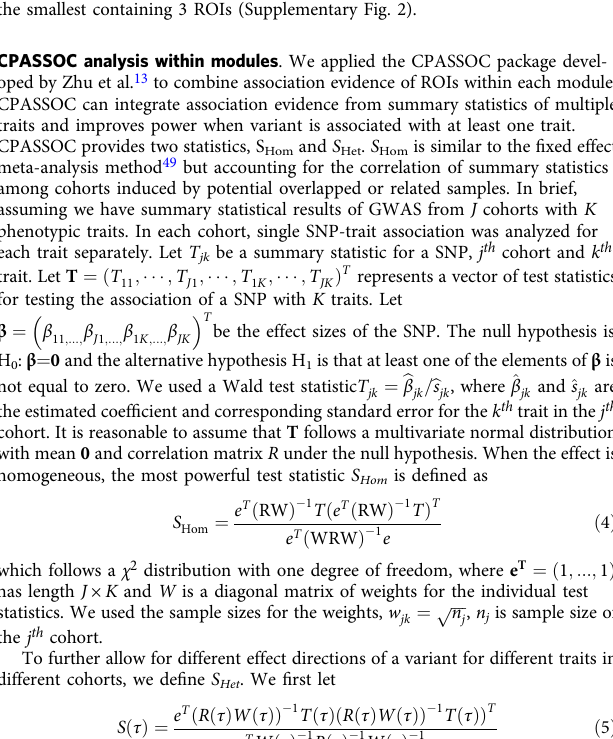
Association test of SNP rs117028417 with phenotypes were performed using linear regression under an additive genetic model in PLINK. Baseline age and sex were included as covariates. We extracted 8 and 15 coding variants de fi ned as missense, in frame deletion/insertion, stop gained/lost, start gained/lost, splice acceptor/donor, or initiator/start codon for FAM222A and TRPV4 respectively (Supplementary Table 4). All of those variants are rare with minor allele